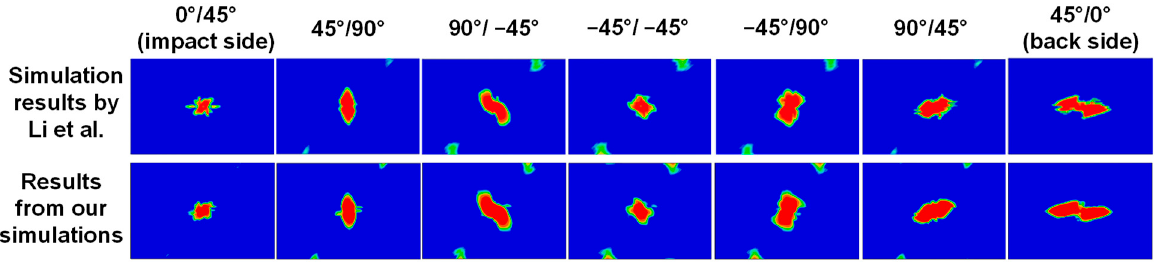
Figure 5. Verification of the low velocity impact model: comparison between simulation results reported in Ref. [49] (first row) and our simulation results (second row) for the same benchmark problem (i.e., low velocity impact at an impact energy of 25 J for a CFRP composite laminate of 150 × 100 mm and a layup of [0 2 /45 2 /90 2 / − 45 2 ] S ). The contour plots from left to right show the delamination patterns at each interface of the composite laminate. The red color indicates complete delamination while the blue color indicates no delamination.